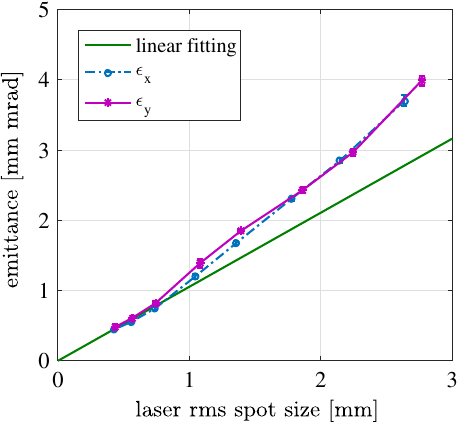
FIG. 7. Measured emittance as a function of laser spot size. The slope of the line in the linear regime (laser spot size < 0 . 75 mm) gives a thermal emittance of 1 . 05 (cid:3) 0 . 04 mm mrad =